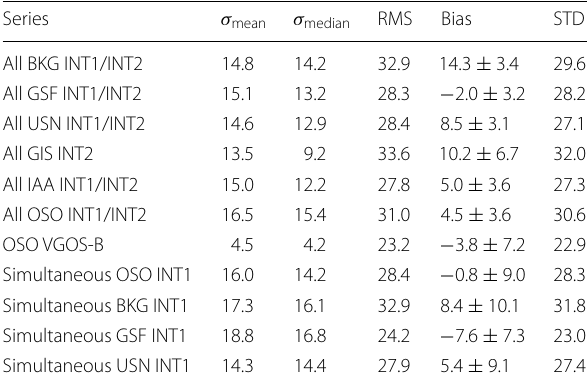
Table 2 Statistics of the UT1-UTC times series. Shown are the mean formal uncertainties ( σ mean ), median formal uncertainties ( σ median ), the (unweighted) root-mean square agreement (RMS) w.r.t. the IERS Bulletin B series, the mean bias and the standard deviation (STD) after removing the bias